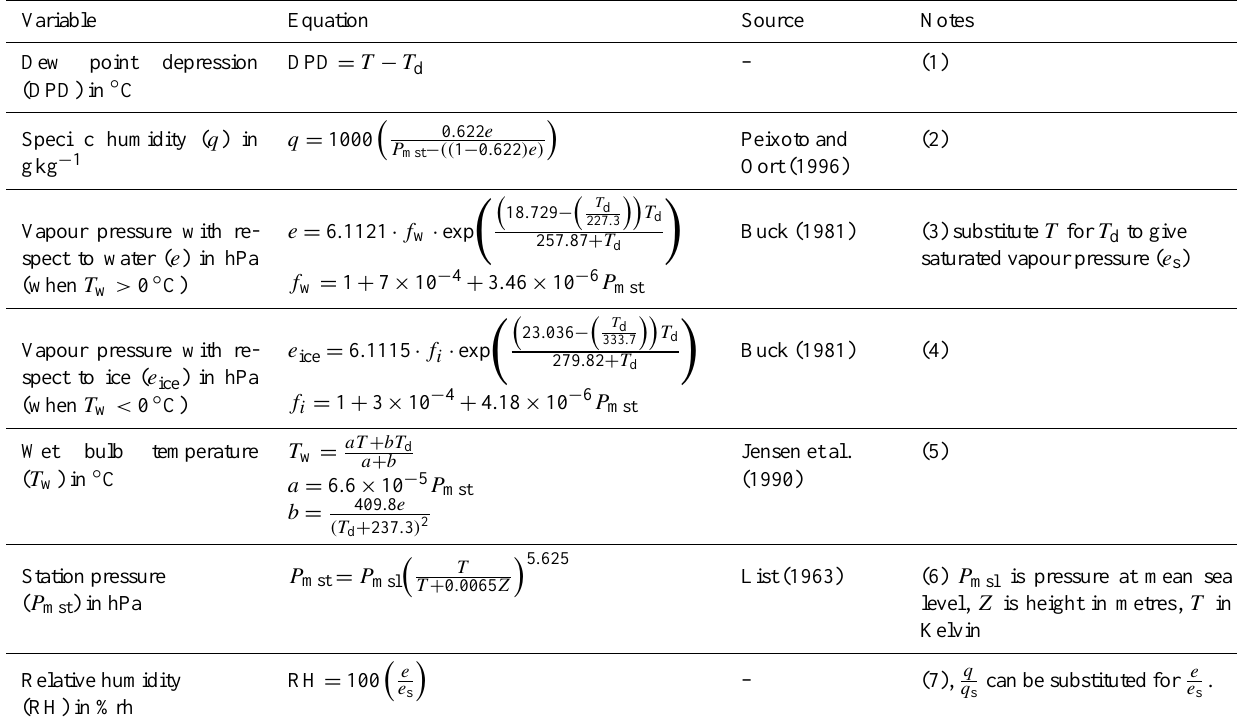
Table 1. Equations (1) to (7) used to derive humidity variables from dry bulb temperature and dew point temperature. Variable Equation Source